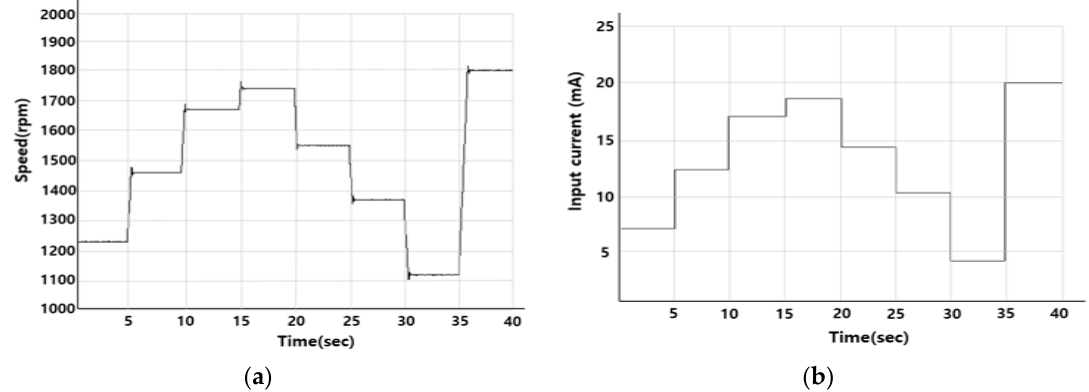
Figure 15. ( a ) random speed of generator, ( b ) output results of the potentiometer input current with respect to random speed command values.